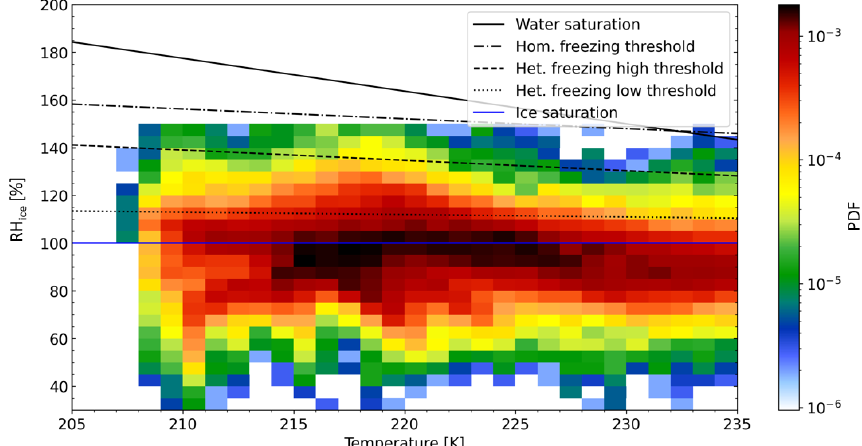
Figure 8. Probability distribution of in-cloud RH ice measured by the lidar WALES below 235K as a function of ECMWF model temperature. Only the cloud particles producing a back-scattering ratio greater than 3 and depolarization greater than 20% are included in the plot. The water saturation (Murphy and Koop, 2005), homogeneous freezing threshold (Koop et al., 2000), and heterogeneous freezing high (mineral dust as ice-nucleating particles) and low (coated soot) thresholds (Krämer et al., 2016) are added in the figure. Ice saturation is also marked by the horizontal blue